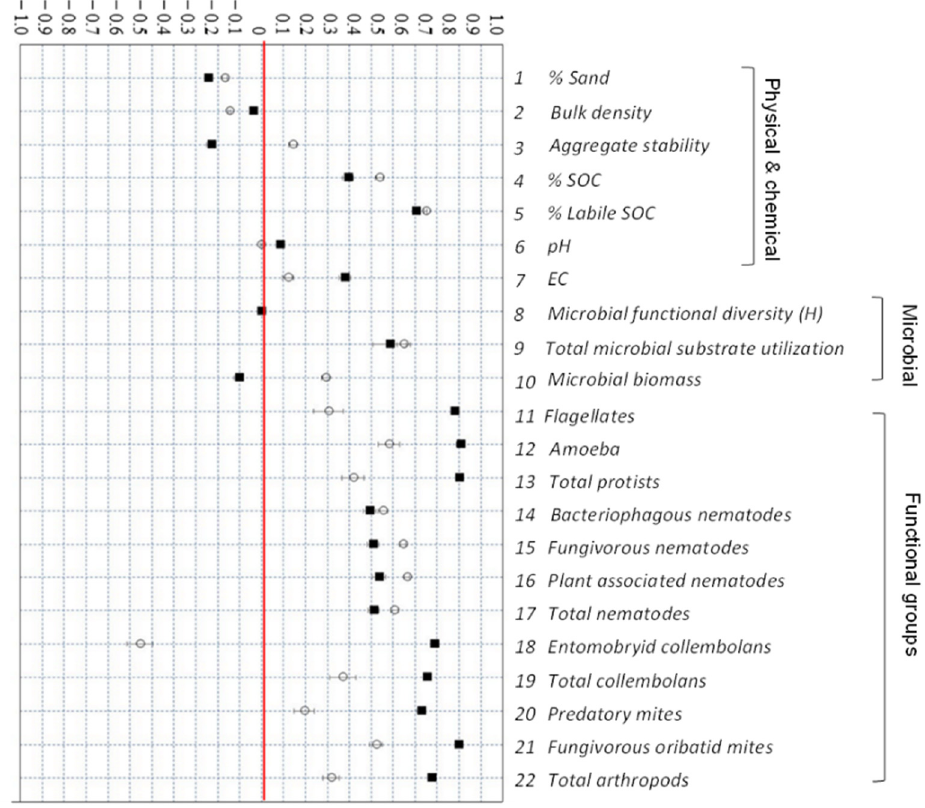
Figure 5. Value of the V Index (mean ± standard error) for differences between the regenerative and intensive vineyards (black squares) and between the minimum impact and intensive vineyards (empty circles). The greater the distance to the reference red line, the greater the difference between treatments. The red line represents the reference value of each soil property in the intensive vine- yard.